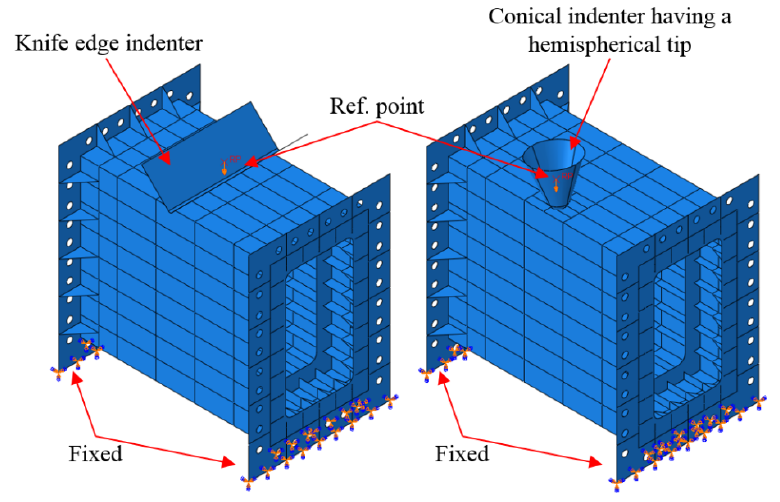
Figure 21. Numerical modeling and boundary condition for the collision simulation.